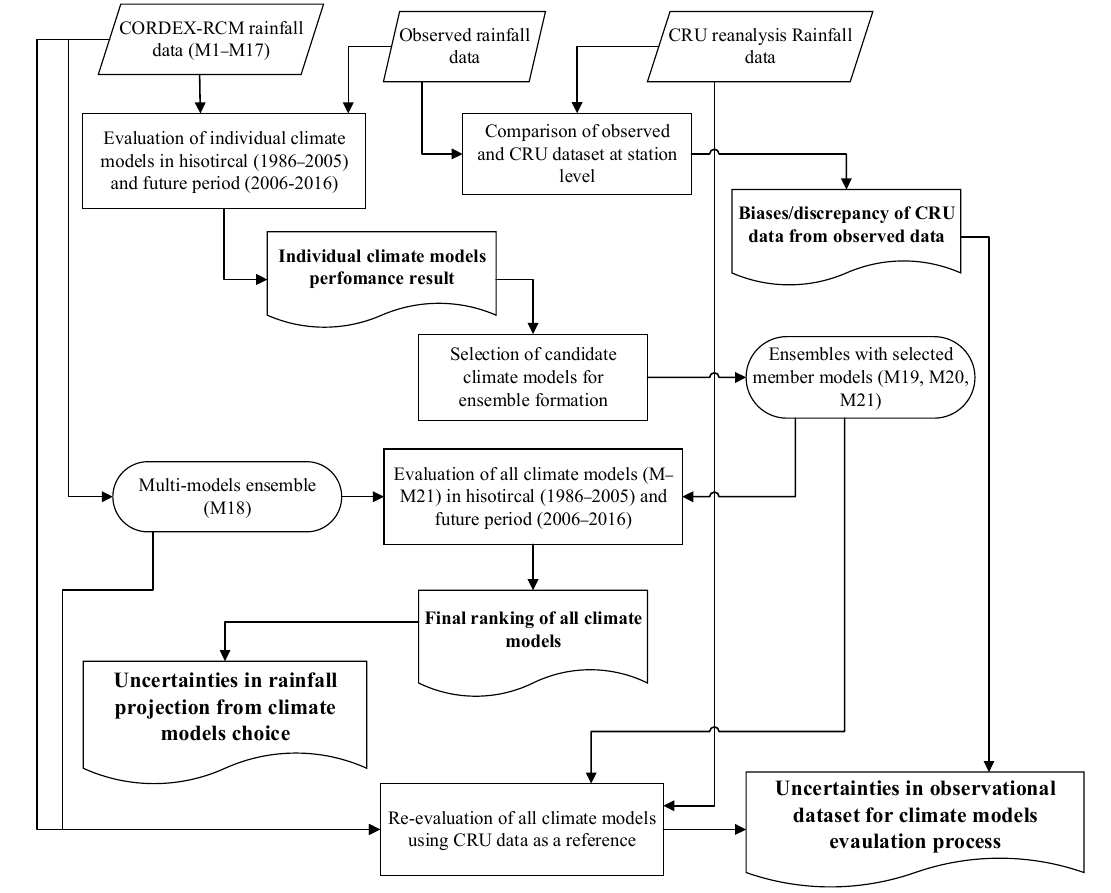
Figure 2. Flow diagram showing the overall methodological frameworks applied in this research (Part of the figure components that are written in bold are the results from the previous analysis in the work flow).